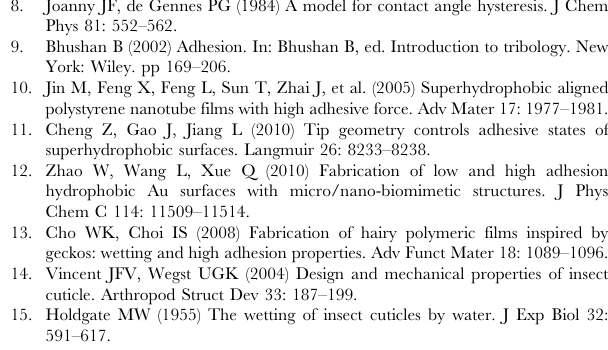
Figure S1 The optical image of water droplet on the fresh sample of wing surface of cicada Cryptotympana atrata collected in the year 2010. (TIF) Figure S2 Optical images of water droplets hanging into four species of cicadas. (A) Leptopsalta bifuscata ; (B) Aola bindusara ; (C) Meimuna opalifer ; (D) Cryptotympana atrata collected in the year 1951. The volume of water droplet is 3 m L in left column and 10 m L in right column. Table S1 Mean values and standard deviations (in brackets) of nanostructure parameters including diameter ( d ), spacing ( s ) and height ( h ) of protrusions, roughness factor ( r ), solid fraction ( Q ) in contact with the liquid, cos h w and cos h c based on the Wenzel and Cassie-Baxter wetting states on dry wing surfaces of four species of